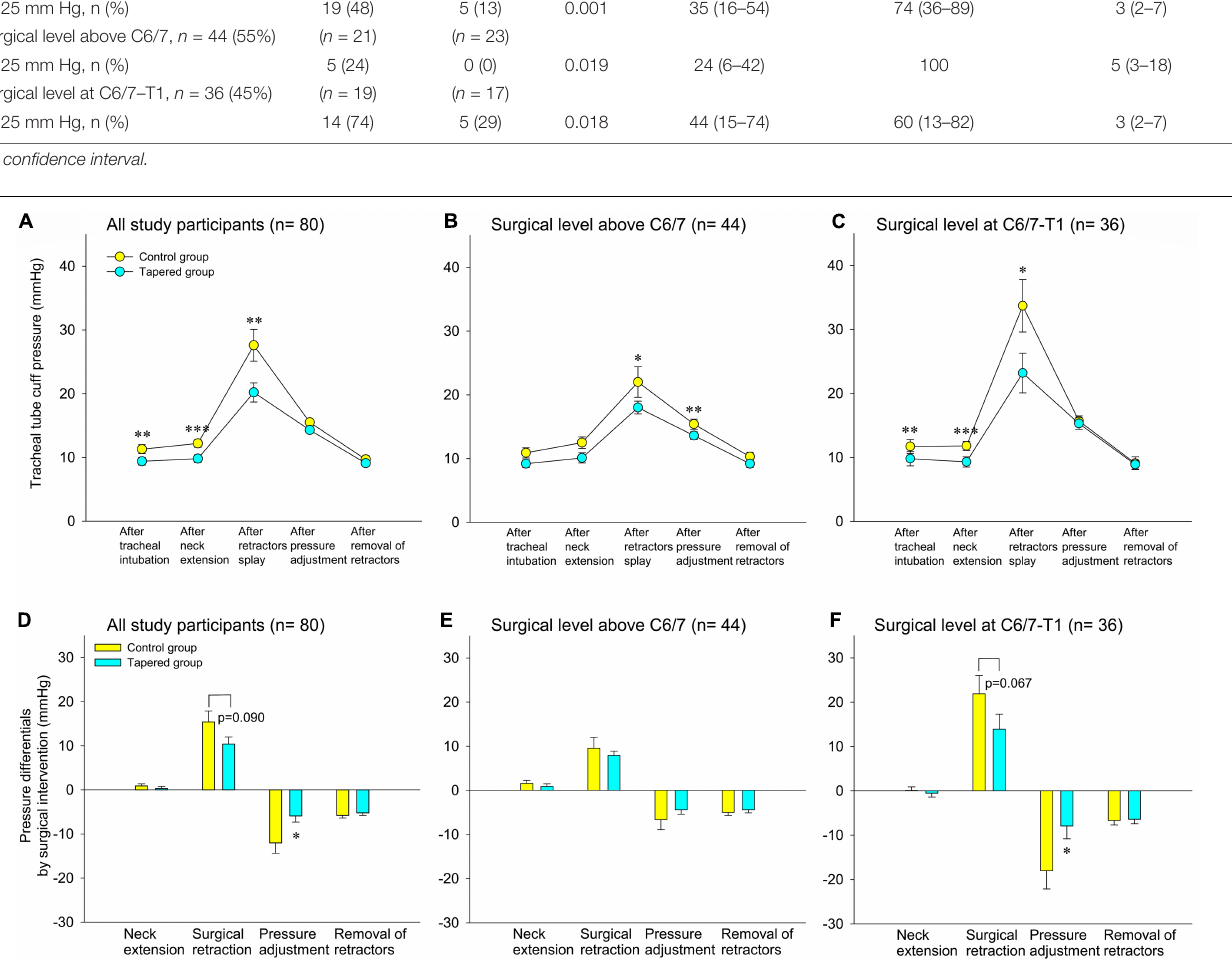
FIGURE 3 | Tracheal tube cuff pressure during surgery (A–C) and pressure differentials by surgical intervention (D–F) . (A,C) All study participants. (B,D) Surgical levels above C6/7. (C,F) Surgical level at C6/7–T1. Data are presented as the mean and the standard error of the mean, ∗ P < 0.05, ∗∗ P < 0.01, and ∗∗∗ P < 0.001. 1 mm Hg = 1.36 cm H 2